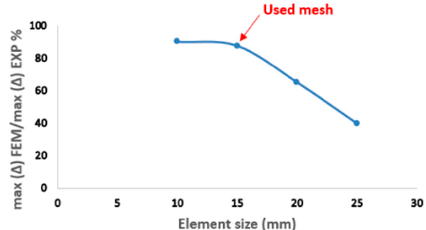
Figure 8. Mesh convergence study.